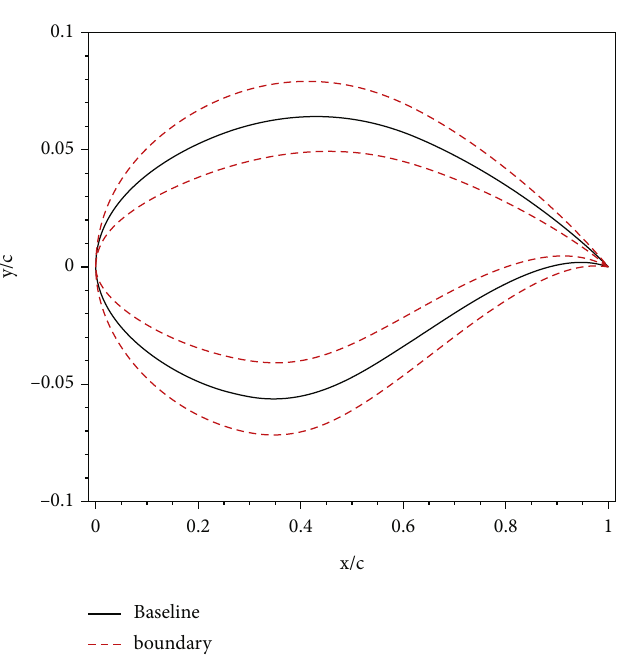
Figure 13: The initial design